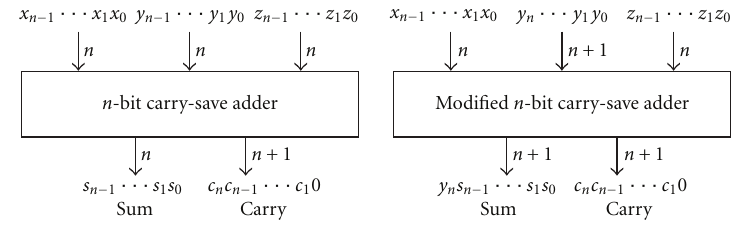
Figure 3: n -bit carry-save adders.